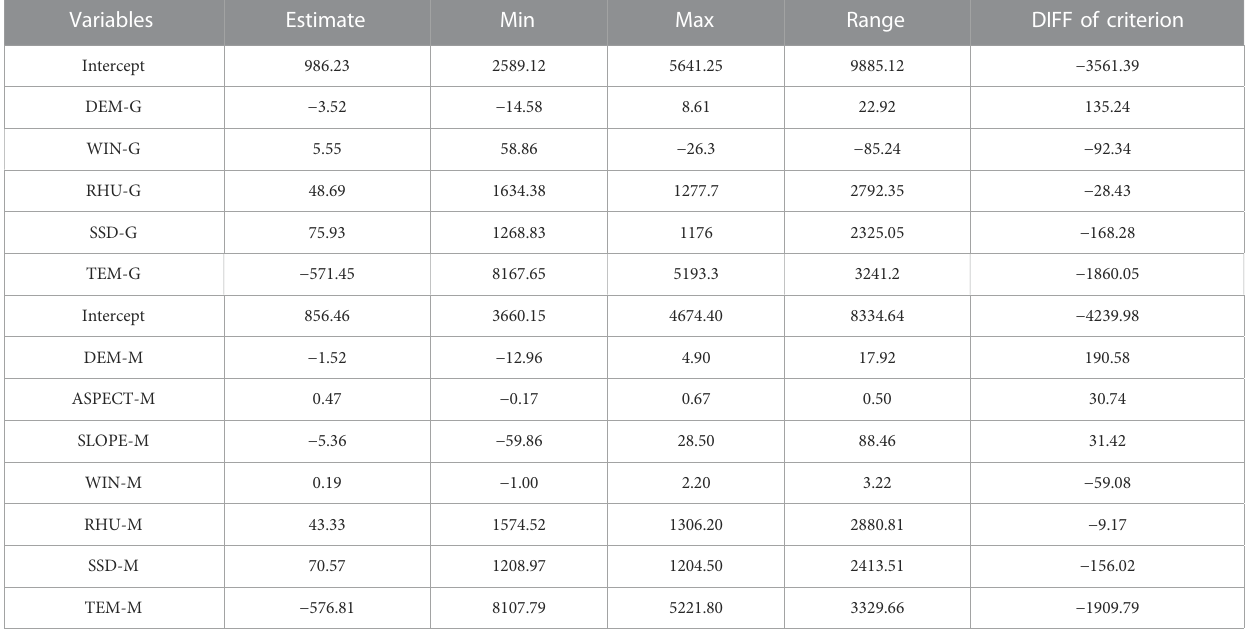
TABLE 1 Geographical Variability Test (GVT) of Environmental Variables based on Standard DIFF.